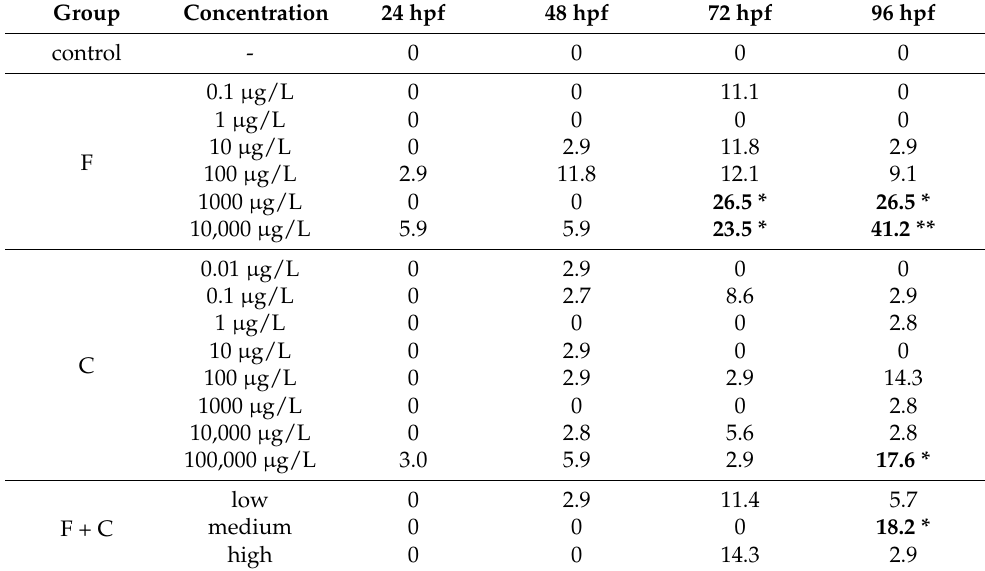
Table 3. Malformations (%) in zebrafish embryos exposed to antidepressants as single substances and as a mixture. The results are related only to living individuals. Bold font and asterisks indicate a significant difference (* p < 0.05, ** p < 0.01) between the control and the experimental groups at the same time of